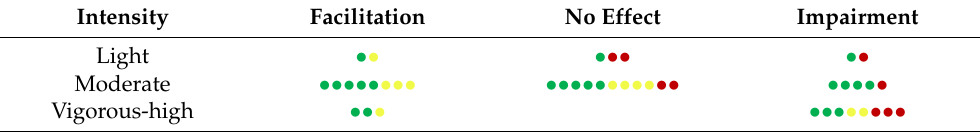
The three exercise intensities included: (1) light-intensity exercise (40 < 55%HR max , 20 < 40%HRR, 20 < 40%VO 2max ) vs. control, (2) moderate-intensity exercise (55 < 70%HR max , 40 < 60%HRR, 40 < 60%VO 2max ) vs. control,